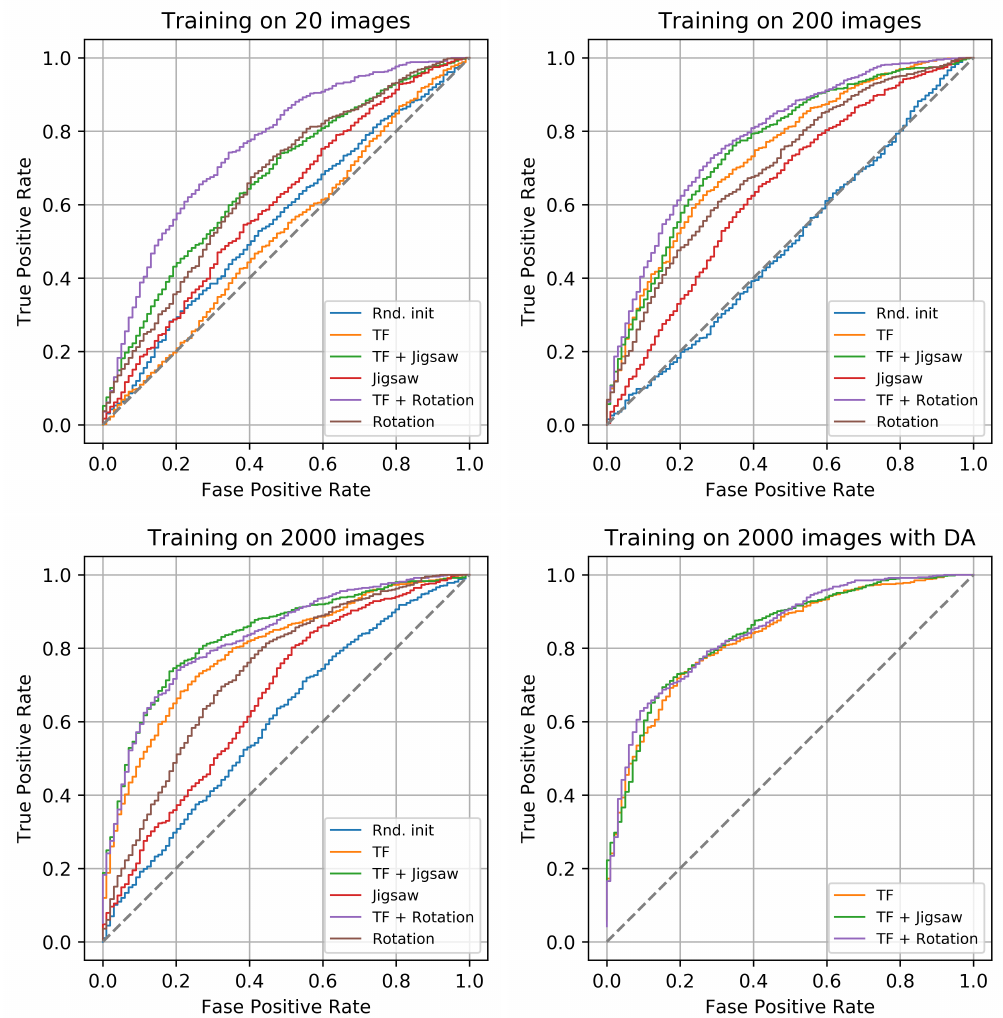
Figure 5. ROC (Receiver Operating Characteristic) curves of evaluated